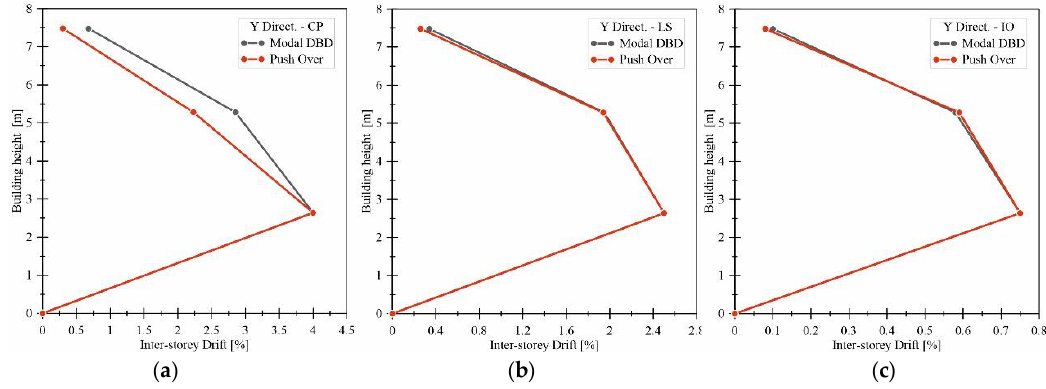
Figure 11. Comparison of inter-story displacements obtained from the Modal-DBD or the PO analyses in the Y-direction ( a ) Collapse Prevention, ( b ) Life Safety and ( c ) Immediate Occupancy.